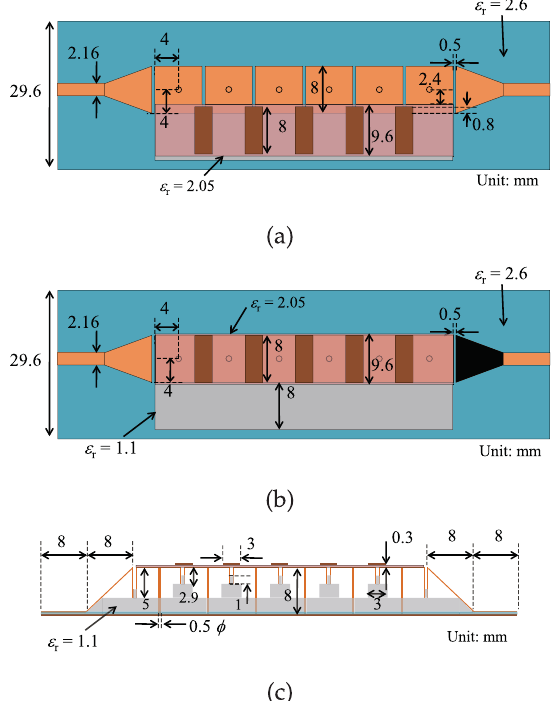
Fig. 13. Con fi guration of fabricated phase shifter composed of 5-cell CRLH transmission line. (a) Top view of crossover of 10%. (b) Top view of crossover of 100%. (c) Side view. Fig. 14. Magnitude of S-parameters characteristics of 5-cell transmission line. (a) Crossover of 10%. (b) Crossover of 100%.